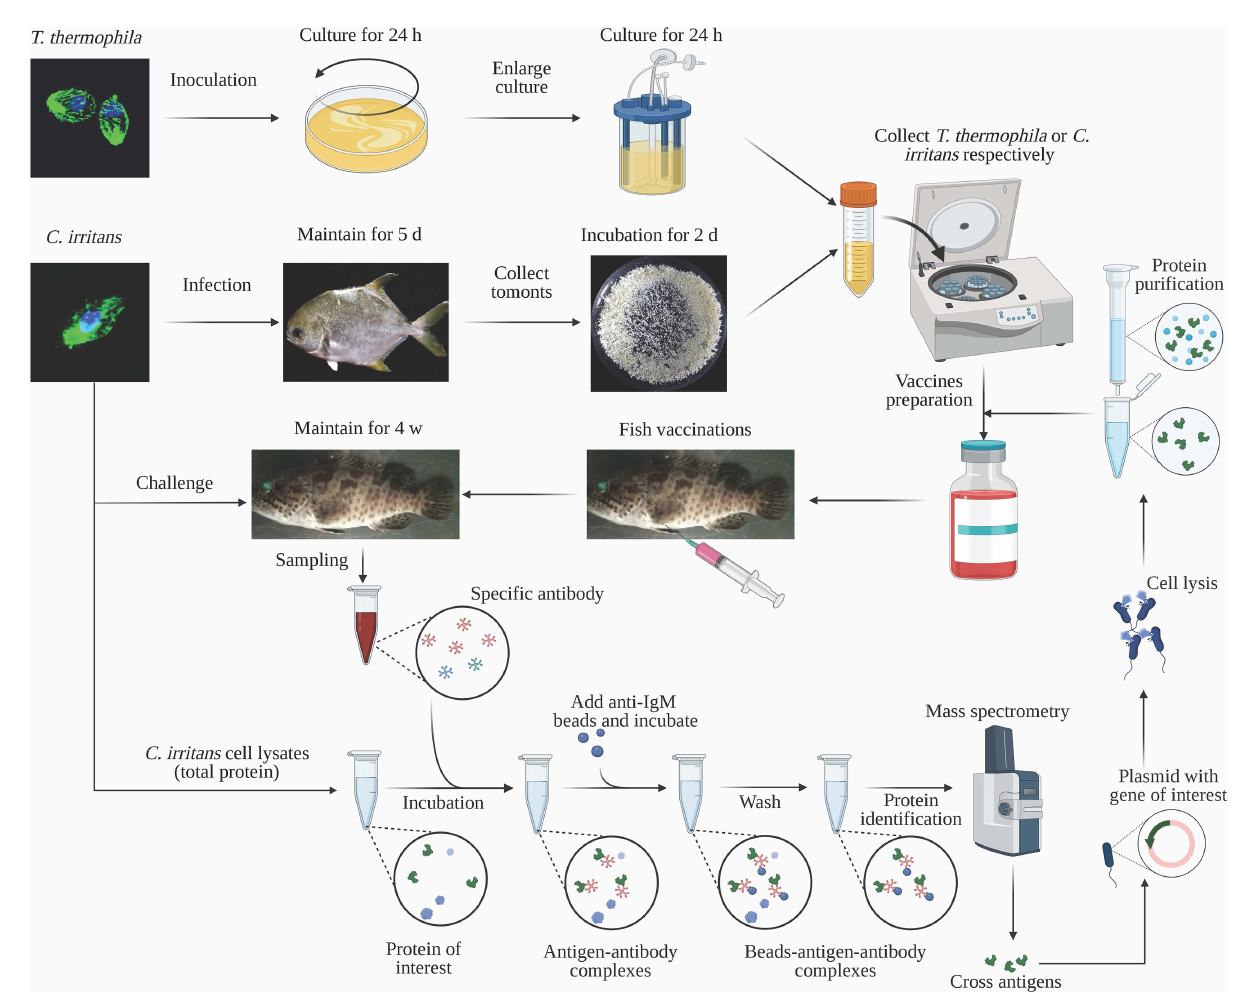
FIGURE 1 | Schematic diagram of heterogenous vaccine development in this study. C. irritans and T. thermophila were cultured and collected for antigen preparation. After emulsifying with adjuvants, vaccines were individually SQ injected into groupers. Four weeks after the boost vaccination, groupers were challenged with C. irritans theronts to measure the infective rate. Serum samples were collected from groupers before the challenge and used for identi fi cation of potential cross-reactive antigens by immunoprecipitation and mass spectrometry analyses. The recombinant potential cross-reactive antigen was prepared by prokaryotic expression and injected into grouper for infective rate detection. The schematic was created using